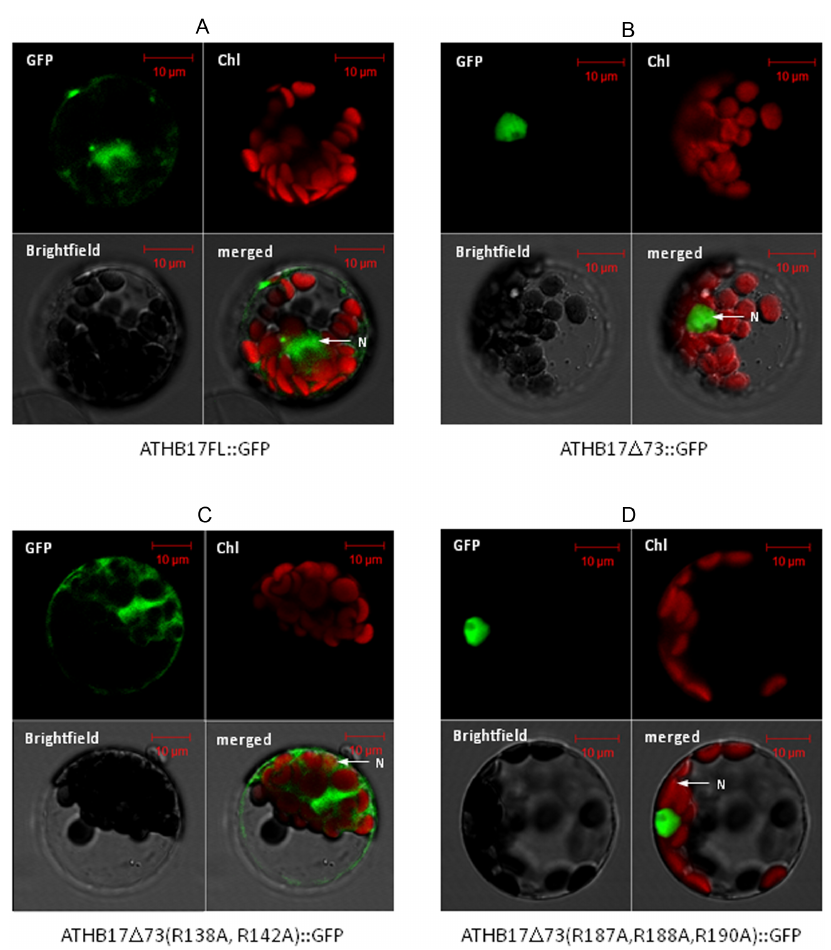
Figure 2. Representative fluorescence micrographs of Arabidopsis mesophyll protoplasts. Purified protoplasts were transformed with (A) full length ATHB17:GFP or (B) a variant lacking the first 73 amino acids (ATHB17 D 73:GFP). The full length ATHB17:GFP fusion protein localizes to the nucleus and cytosol (A) in Arabidopsis protoplasts and ATHB17 D 73:GFP is localized exclusively in the nucleus when the unique N- terminus is removed (B). Two regions with a cluster of basic (K and R) residues were identified as putative nuclear localization signals. The arginine residues were mutated to alanines in these regions in the D 73 variant to disrupt translocation. (C) R138A and R142A mutations in ATHB17 D 73 disrupted nuclear retention while (D) R187A, R188A and R190A mutations did not alter the nuclear localization of the D 73 variant.